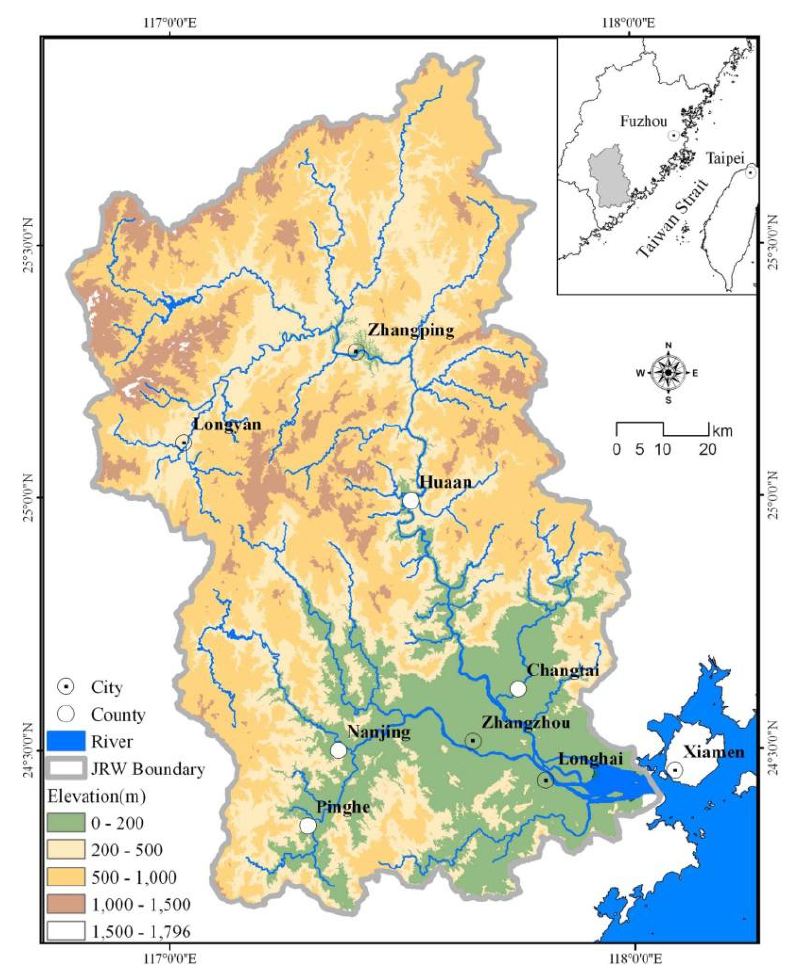
Figure 1. Location of the Jiulong River